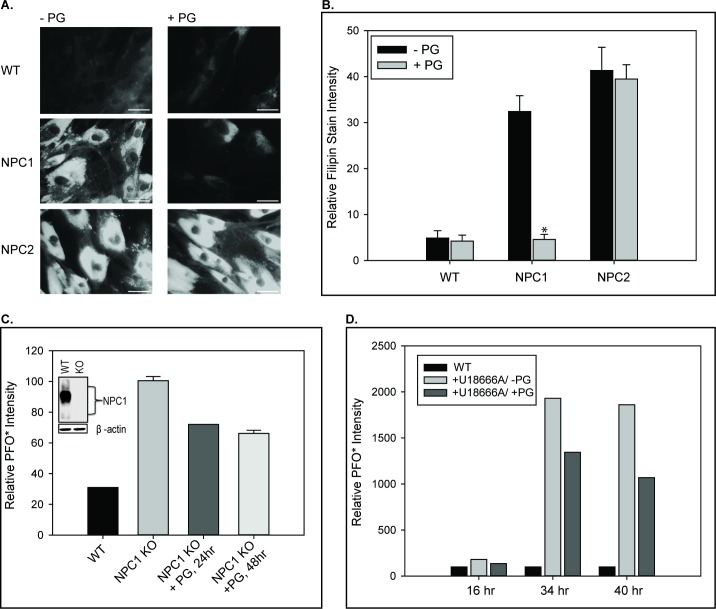
PG supplementation reverses cholesterol accumulation in NPC1– but not NPC2–deficient cells.WT, NPC1–, and NPC2– deficient fibroblasts were incubated with 100 µM PG SUVs and cholesterol accumulation was determined by filipin staining as described under Methods. (A) Representative images of untreated and PG supplemented fibroblasts stained with filipin. Scale bars, 70 µM. (B) Percent filipin stain intensity, relative to control condition. Data are representative of three individual experiments, ± SE. *p<0.01 vs untreated cells by Student’s t-test. The effect of PG supplementation on cholesterol accumulation in NPC1-deficiency was also measured by PFO* intensity, assessed via flow cytometry, in (C) CRISPR-Cas9 mediated NPC1 knockout HeLa cells and (D) WT human fibroblasts treated with 1 µM U-18666A. Data are expressed relative to (C) untreated NPC1 knockouts and (D) untreated WT fibroblasts per incubation period.